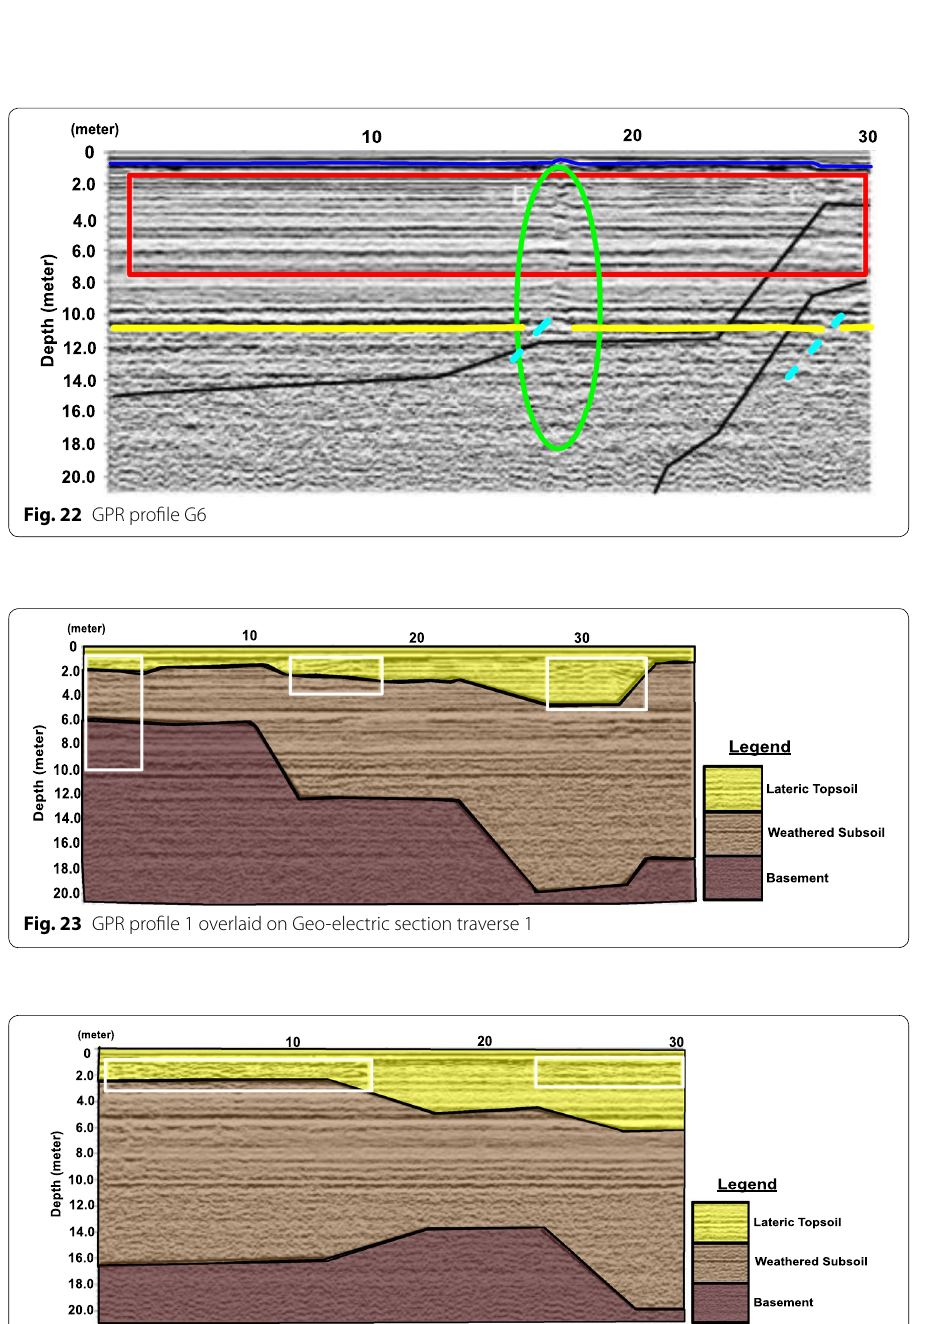
Fig. 24 GPR profile 2 overlaid on Geo-electric section traverse